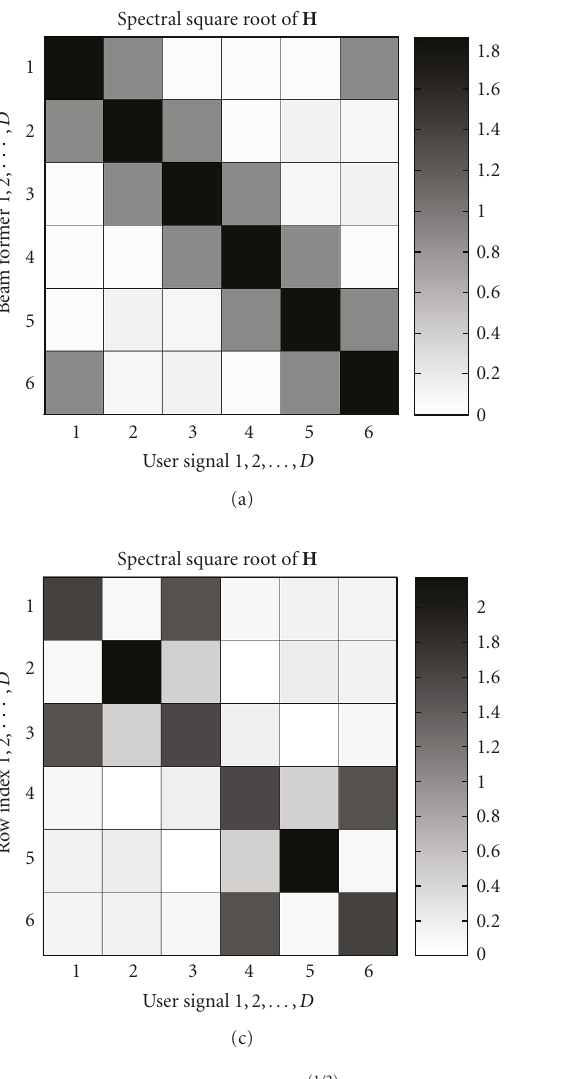
Figure 3: (a) Spectral square root ( H H H ) (1 / 2) of H and (b) sparsity matrix P for a 5-element UCA. The users are uniformly spaced in AOA. (c) Spectral square root ( H H H ) (1 / 2) of H and (d) sparsity matrix P for a 5-element ULA. The user AOAs are uniform within θ max = ± 60 ◦ . There are D = 6 equal energy users. Elements with “ 1 ” in P are obtained by using the SEAIR and SSSER criteria with thresholds T 1 = 2 and T 2 = 0 . 1,